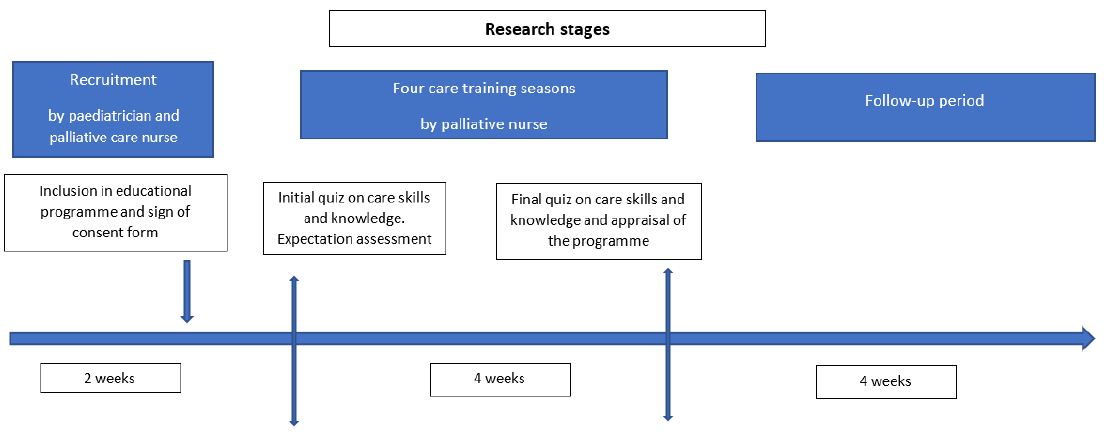
Figure 1. Research Figure 1. Research stages